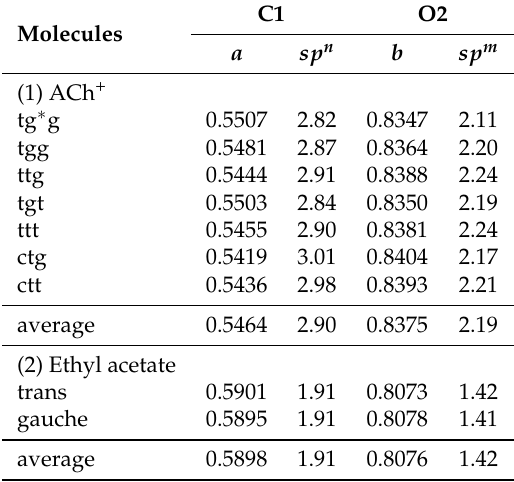
Table 6. The Natural Bond Orbital (NBO) calculation for the C1–O2 bonding based on the linear combination of atomic orbitals a C1 ( sp n ) + b O2 ( sp m ) .